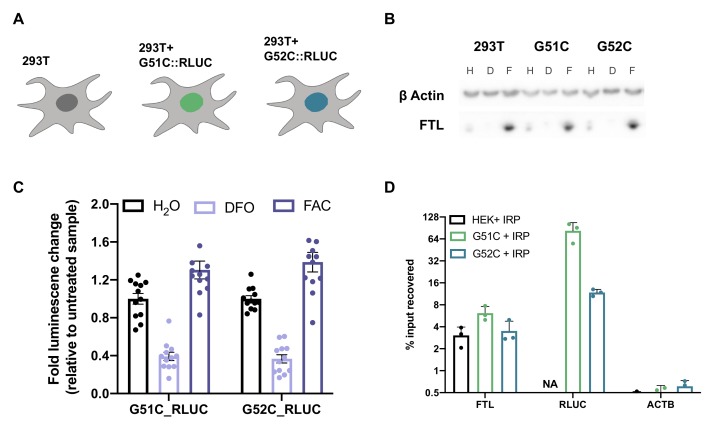
Iron responsiveness of hyperferritinemia associated SNPs in the FTL 5’-UTR.(A) Schematic of the stable lentivirus lines generated that contain the rLUC reporters. (B) Representative western blot demonstrating the inherent iron responsiveness in the generated cell lines vs wild-type cells. This experiment was done in biological triplicate. Iron donor treatment with FAC at 50 µg/mL for 24 hr or iron chelation treatment with DFO at 200 µM for 24 hr. (C) Luciferase activity of the stable hyperferritinemia reporter cell lines after iron treatment. This experiment was done with 12 biological replicates. Error bars represent standard error of the mean. (D) Determination of IRP1 binding to FTL mRNA in WT (HEK + IRP) and various SNP reporter mRNAs (G51C + IRP, G52C + IRP) in HEK293T cells via FLAG immunoprecipitation (IP) followed by RNA extraction and RT-qPCR. The ACTB mRNA was used to control for nonspecific mRNA binding to FLAG-tagged IRP or beads. HEK – IRP reflects cells that were not transiently transfected, but were carried through the IP and following experiments. Error bars represent the standard deviation for the experiment carried out in biological triplicate, with measurements from representative IP reactions carried out in technical triplicate.10.7554/eLife.48193.026Figure 4—figure supplement 2—source data 1.Luciferase reporter readouts and data analysis of FLAG-tagged IRP1 immunoprecipitations.